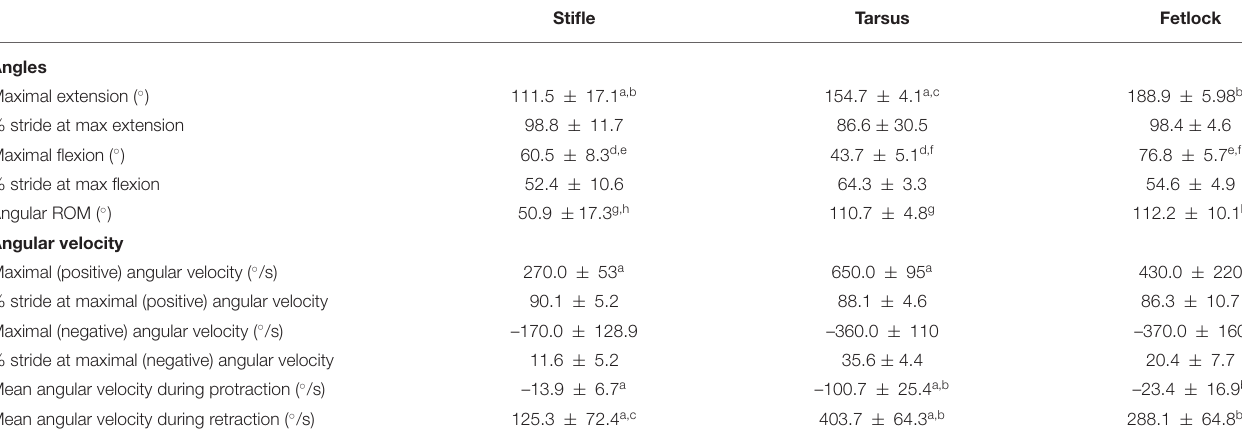
TABLE 2 | Mean ± SD joint angle parameters in horses during free swimming (n = 9 for tarsus/fetlock; n = 8 for stifle).